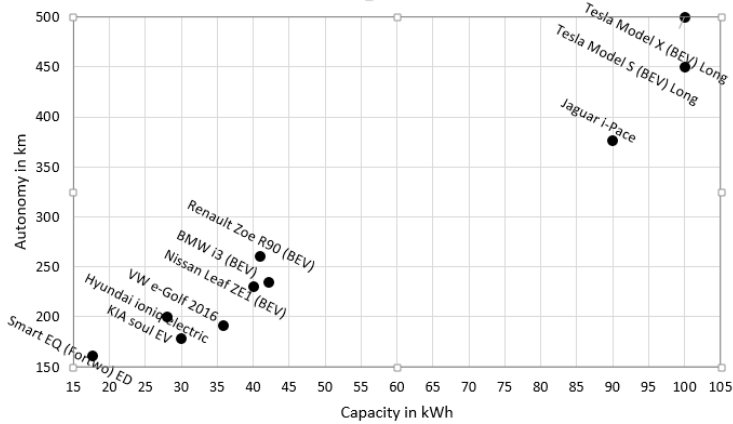
Figure 3. Battery performances.